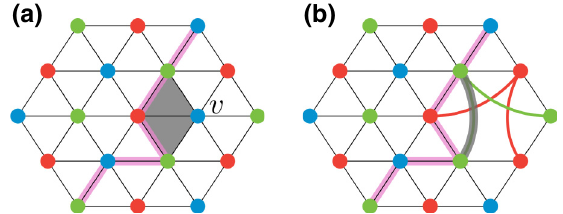
FIG. 18. The local-lift subroutine of our HCT-code decoder.